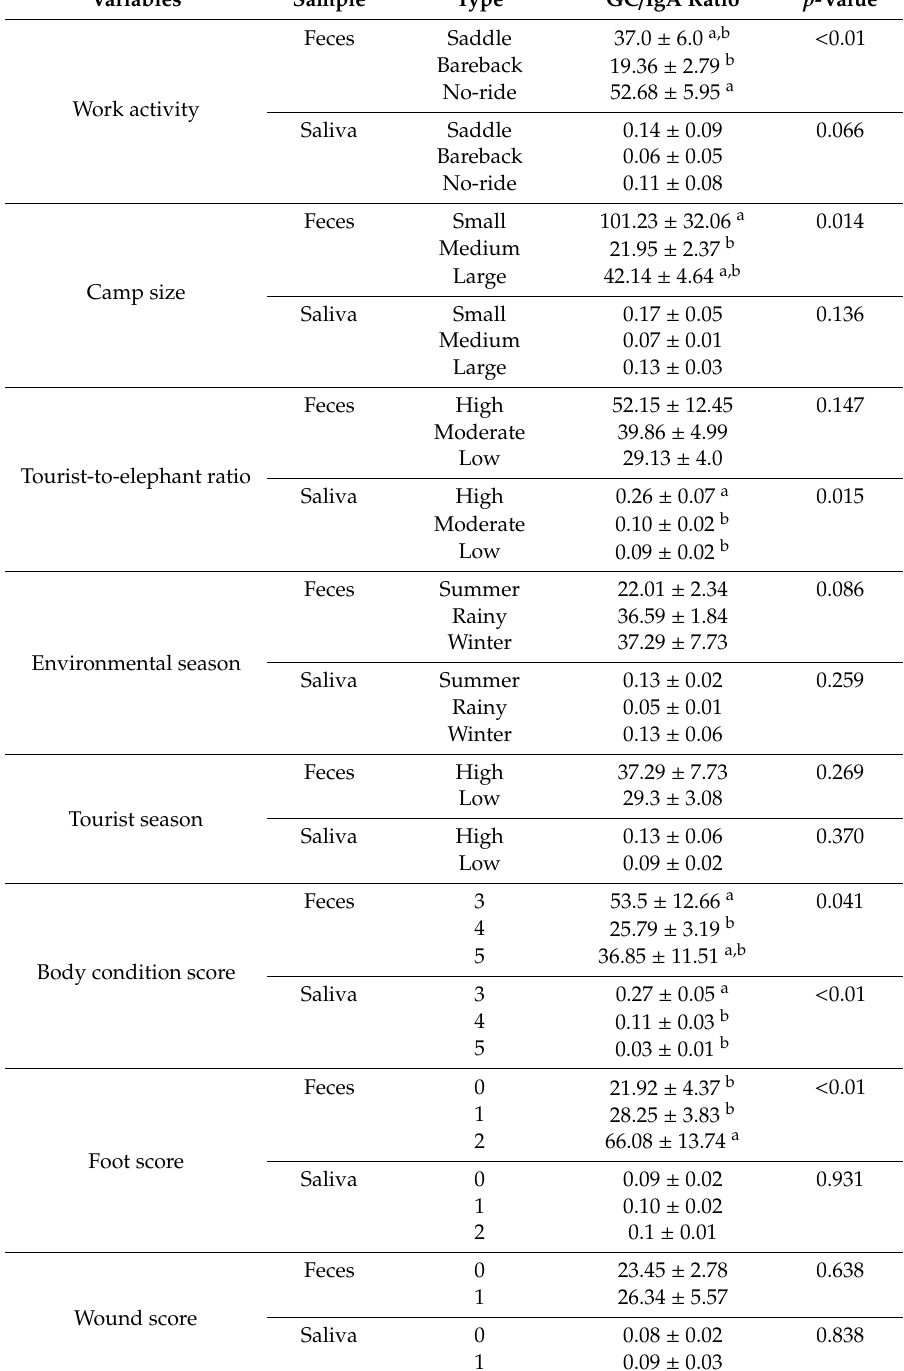
Table 3. Overall mean fecal and salivary GC to IgA ratios calculated from the same biological sample compared between camp and physical